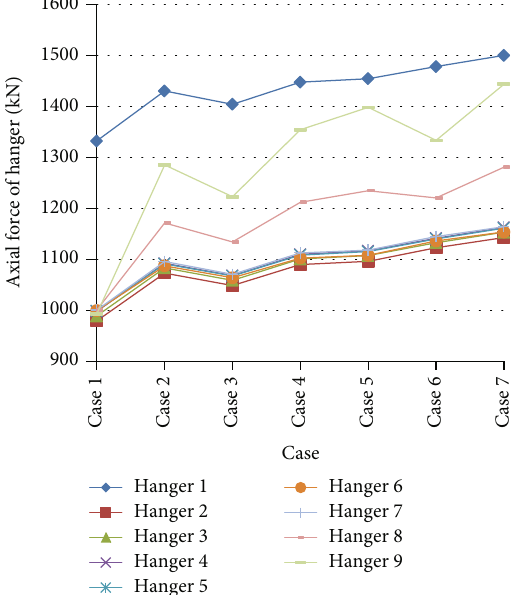
Figure 11: The variation curve of hanger axial force on north side of arch bridge with